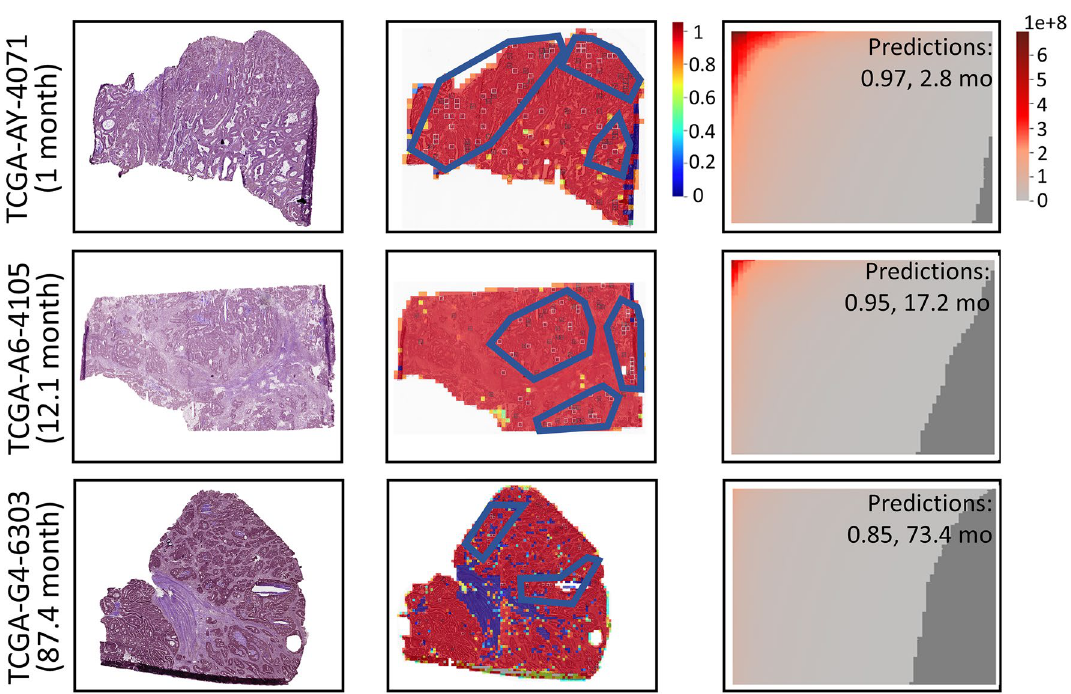
Figure 14. The original WSIs (left), patch-wise probability maps (middle), and HipoMaps (right) of the three patients, who survived one month (TCGA-AY-4071), 12.1 months (TCGA-A6-4105), and 54.3 months (TCGA-G4-6303) in